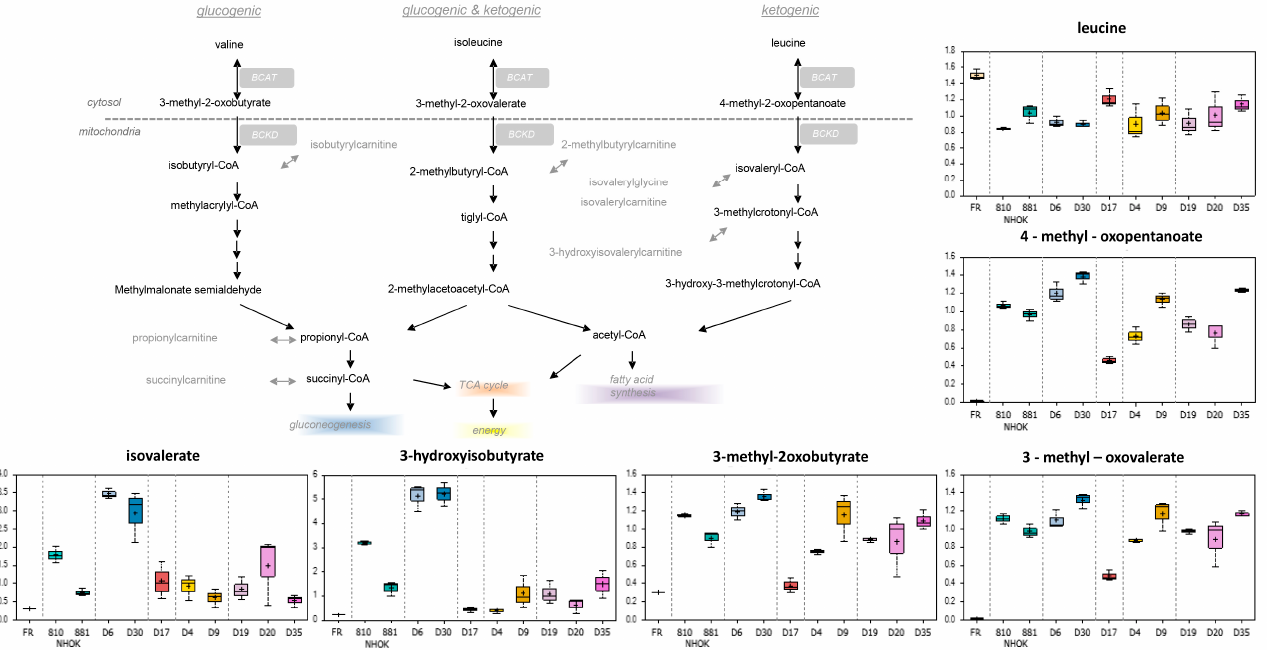
Figure 3. Alterations of the branch chain amino acid pathway in PPOL and normal keratinocytes. The normal keratinocytes are shown in green, the LR MPPOL keratinocytes in blue, the HR IPPOL keratinocytes in yellow (D4 and D9) and purple (D19, D20 and D35), and the LR PPOL p16 INK4A − / − line D17 in brown. Data represents the means of three independent experiments +/ − standard deviation. For statistical analyses see Supplementary Tables S3–S7. BCAT = branched-chain amino acid transaminase; BCKD = Branched-chain alpha-keto acid dehydrogenase complex.